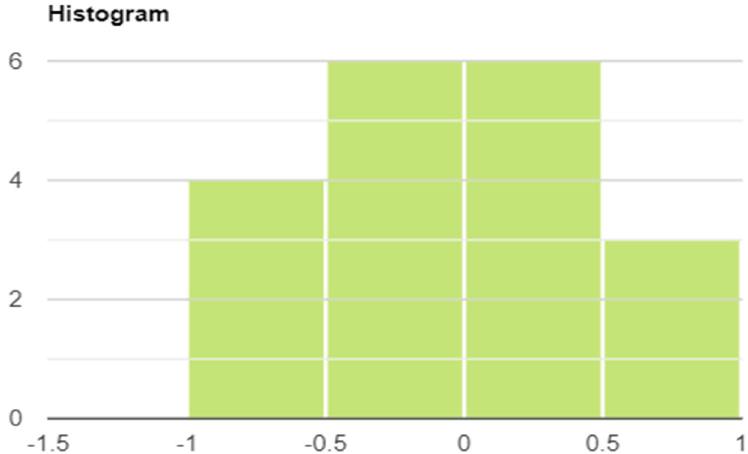
Figure 2. Clusters of GDP change affect the government debt ratio. Note: the number of member states on the y ‐ the first and the four clusters [ − 1.0; 1.0] on the x ‐ axis are based on the correlation coefficients.